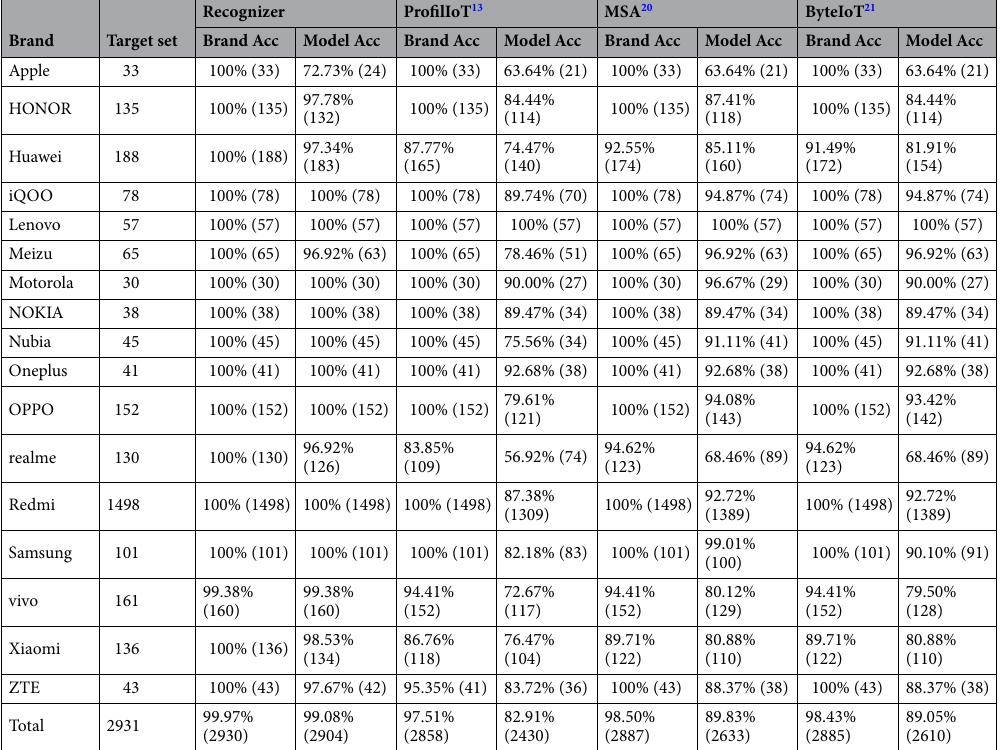
Table 5. Recognition accuracy values of four methods in different brands.